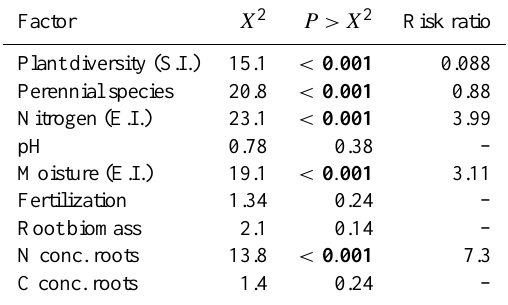
Table 6. Summary of proportional hazards fit in grasslands ( n = 27). Risk ratios < 1.0 represent a positive effect on fine root mean age, and risk ratios > 1.0 represent a negative effect. Results in bold indicate significant results ( p < 0.05). (E.I. = Ellenberg in- dicator values, S.I. = Shannon